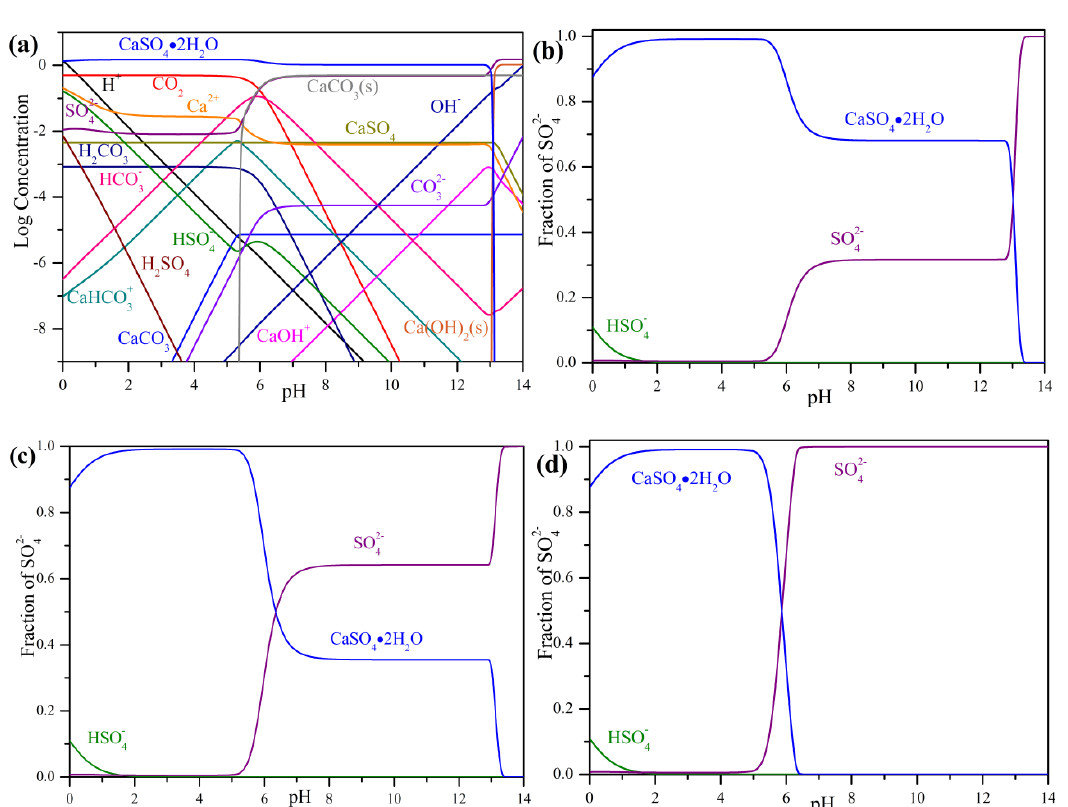
Figure 7. Calculated species distributions of carbonation process without filtration at different pH: ( a ) C CO 2 = 0.1 M with log concentration vs. pH; ( b ) C CO 2 = 0.1 M with fraction of sulfate vs. pH; ( c ) C CO 2 = 1 M with fraction of sulfate vs. pH; and ( d ) C CO 2 = 2 M with fraction of sulfate vs. pH.